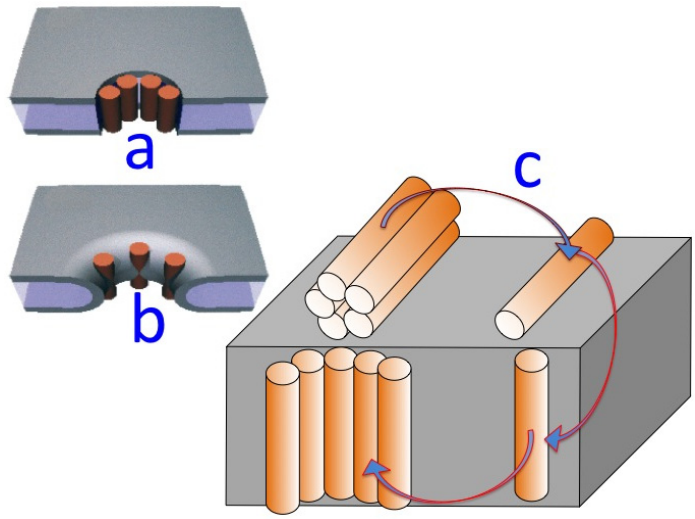
Figure 9. Schematic pictures of a barrel-stave model ( a ); of a toroidal model ( b ); and of the gradual passage from a “flat cluster” to an “embedded cluster” ( i.e. , an ion channel) via a “flat monomer” and an “embedded monomer” ( c